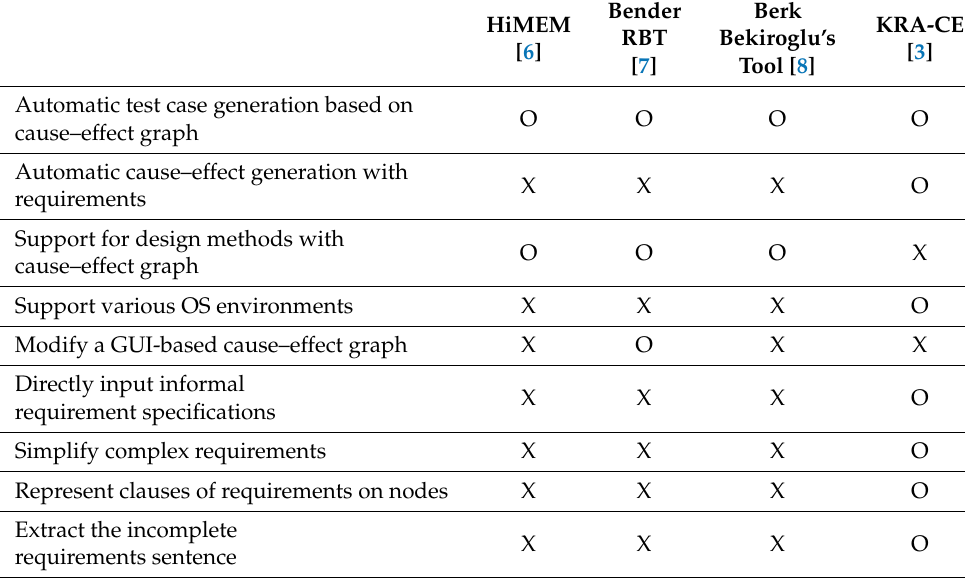
Figure 2. The cause–effect graph generation process based on informal Korean requirement specifi-